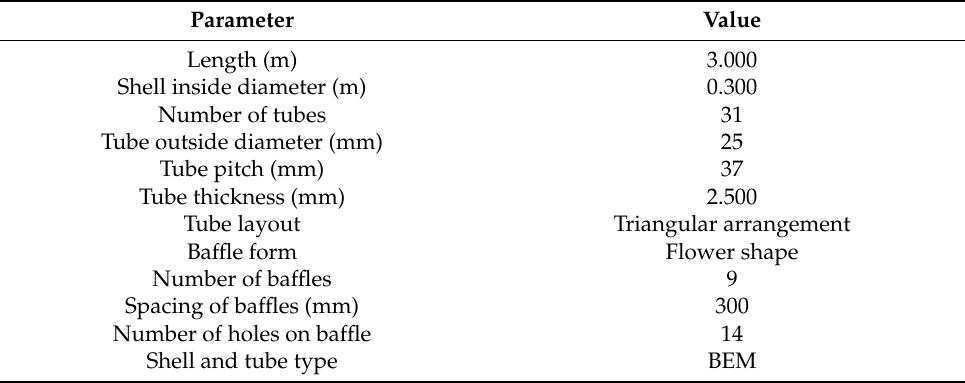
Table 1. Geometric parameters of the heat exchanger.